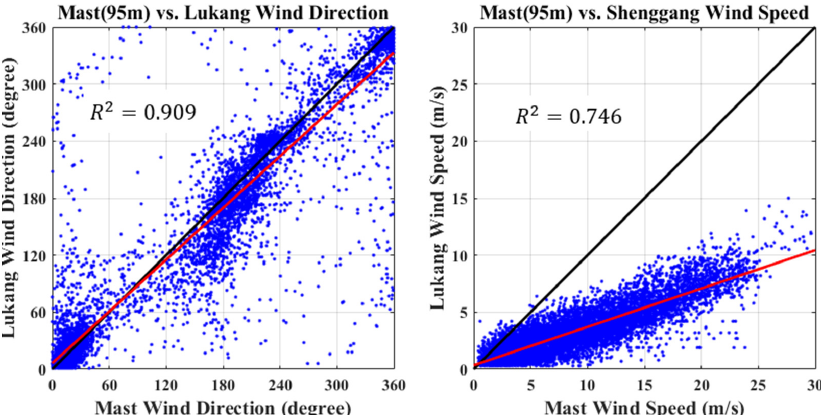
Figure 13. Correlation coefficient of wind direction data between mast and CWB Lukang (left) and of wind speed data between mast and CWB Shenggang (right).